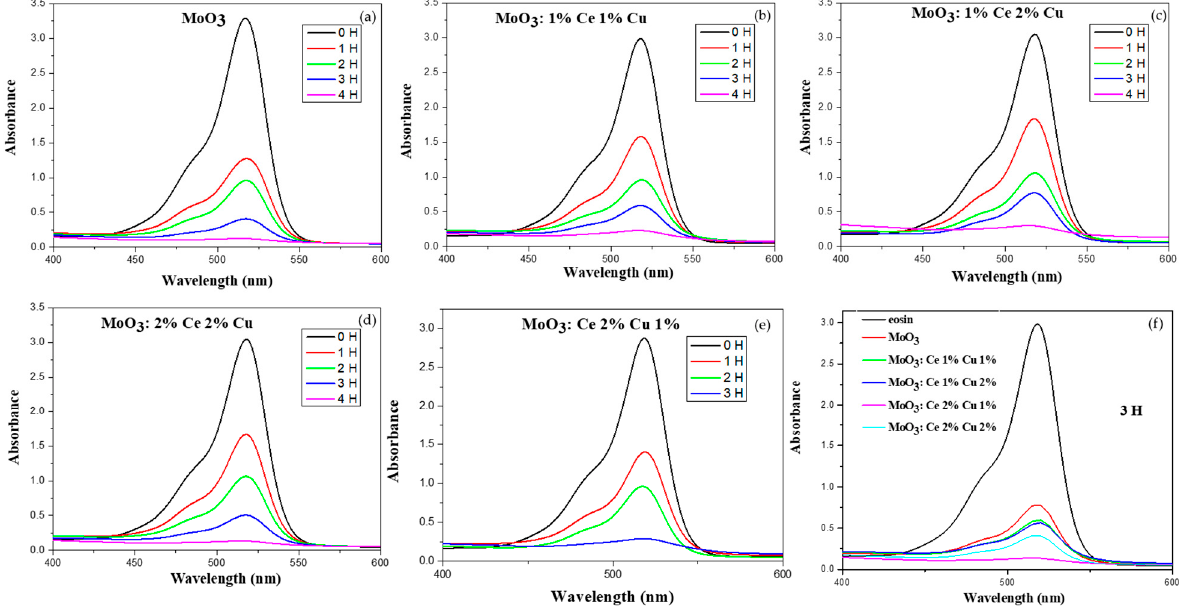
Figure 5. UV-VIS spectra of photodegradation of Eosin-Y under sunlight, with and without MoO 3 :Ce2% Cu1% catalyst thin film for [S] = 40 × 10 − 3 M after (1, 2 and 3 H). ( a ) MoO 3 ( b ) MoO 3 :Ce 1% Cu 1% ( c ) MoO 3 :Ce 1% Cu 2% ( d ) MoO 3 :Ce 2% Cu 1% ( e ) MoO 3 :Ce 2% Cu 2% and ( f ) Eosin-Y.